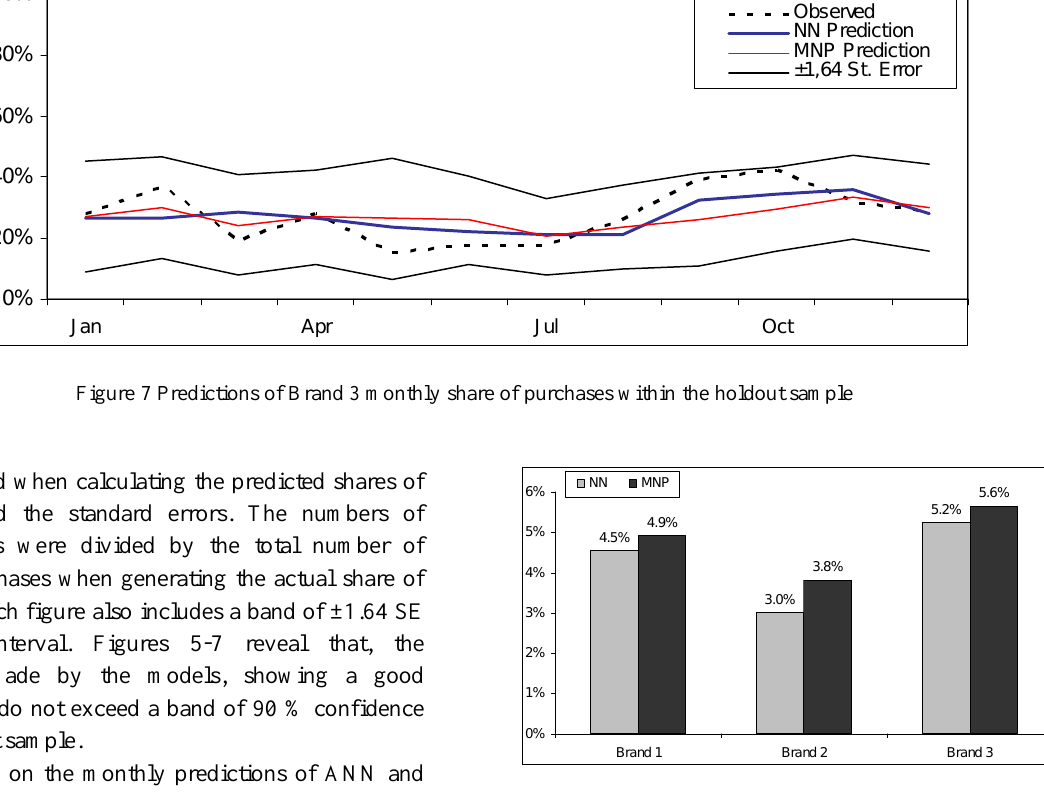
Figure 8 Mean absolute distances between observed and predicted